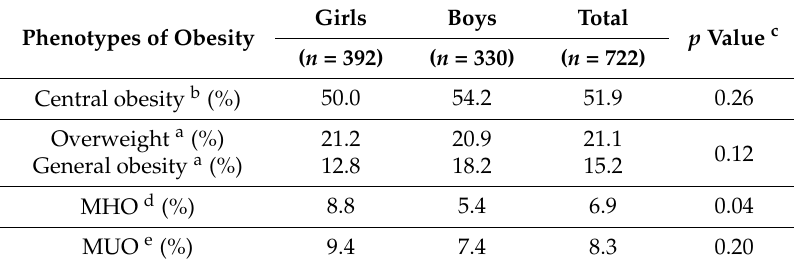
Table 1. Percentage of adolescents with overweight, general obesity and central obesity in the Tehran Lipid and Glucose